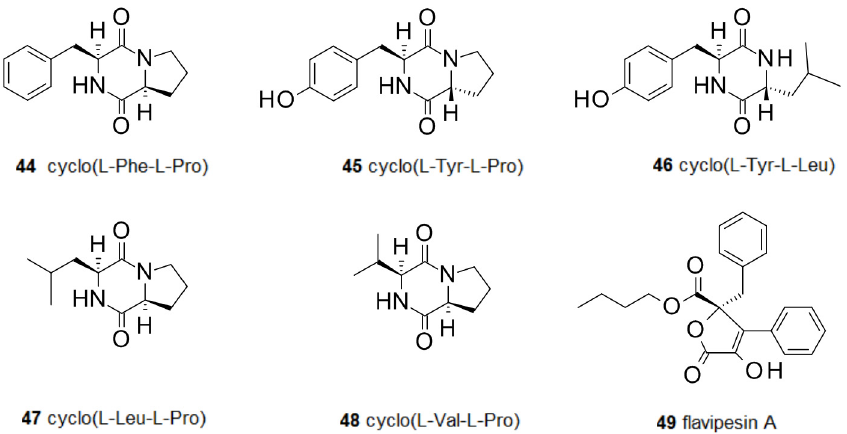
Figure 5. Biofilm-controlling metabolites from fungi derived from amino acids.